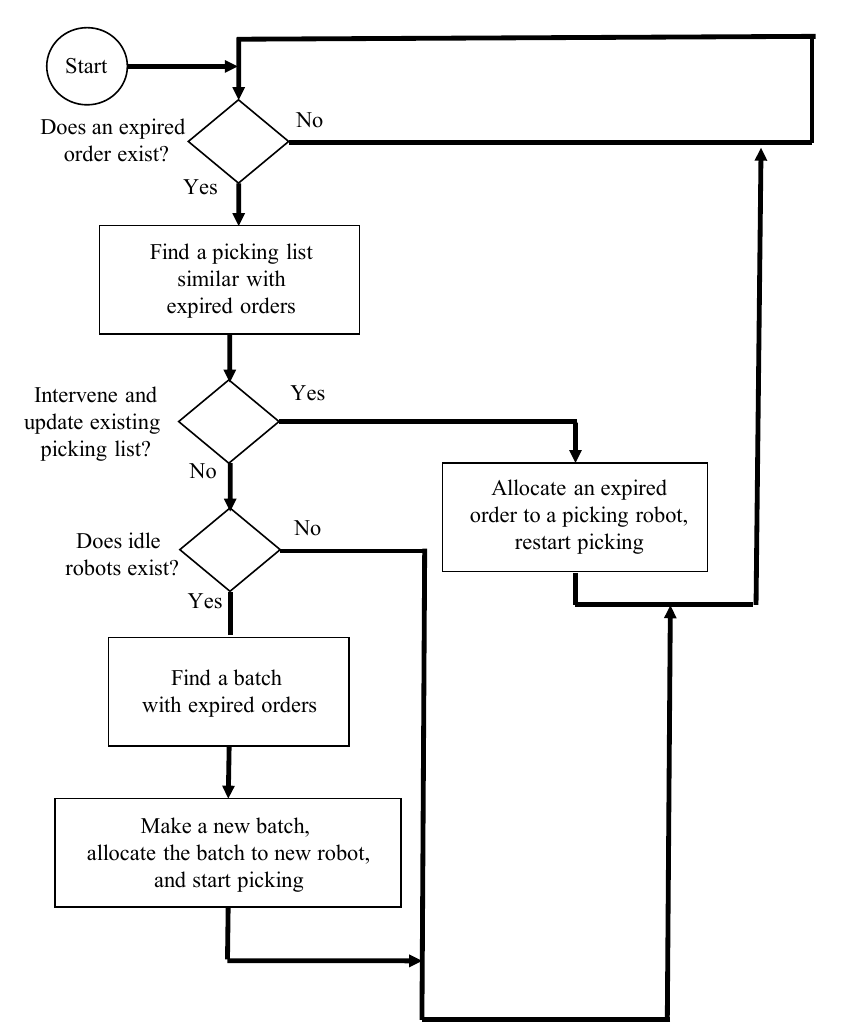
Figure 3. Waiting orders processing flowchart. Orders that have been waiting for a long time until the expired time must be processed to meet the fast completion time of the